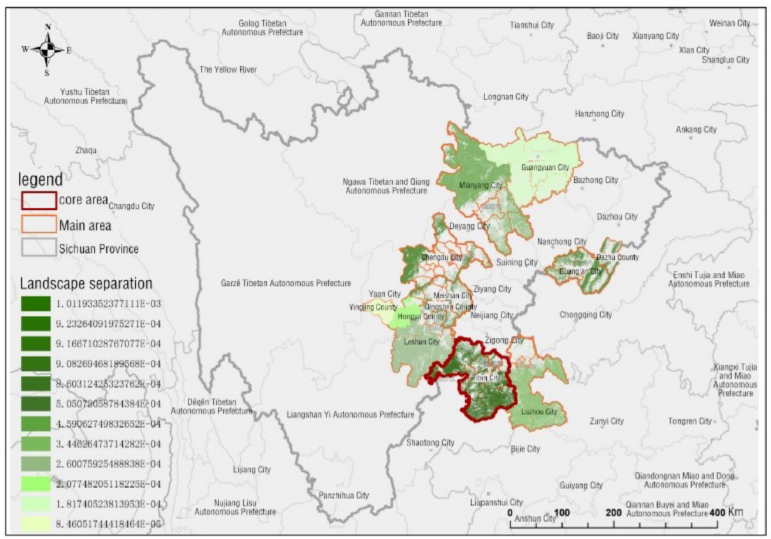
Figure 20. Landscape pattern index (landscape separation) of research areas in Sichuan Province.